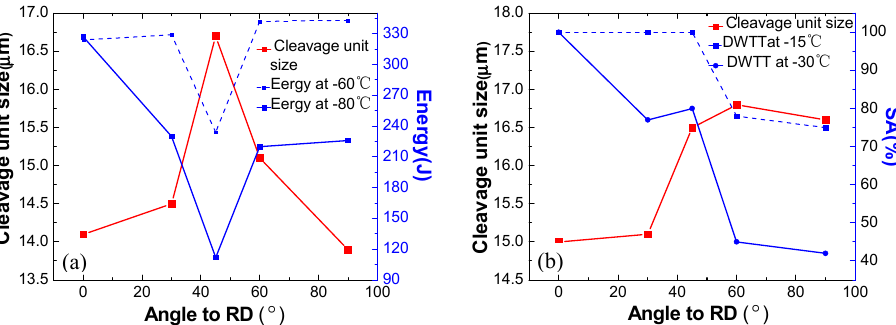
Figure 12. Relationship between toughness and cleavage unit size in different directions: ( a ) curve between impact energy and cleavage unit size, ( b ) curve between SA% and cleavage unit size.